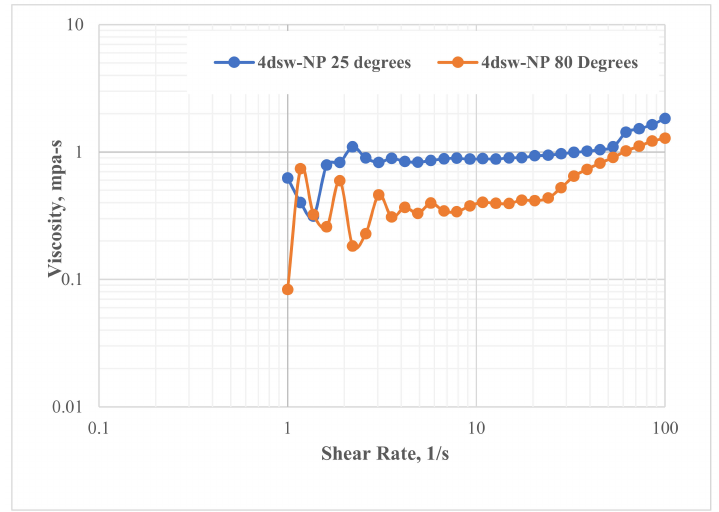
Figure 9. Rheological behaviour of